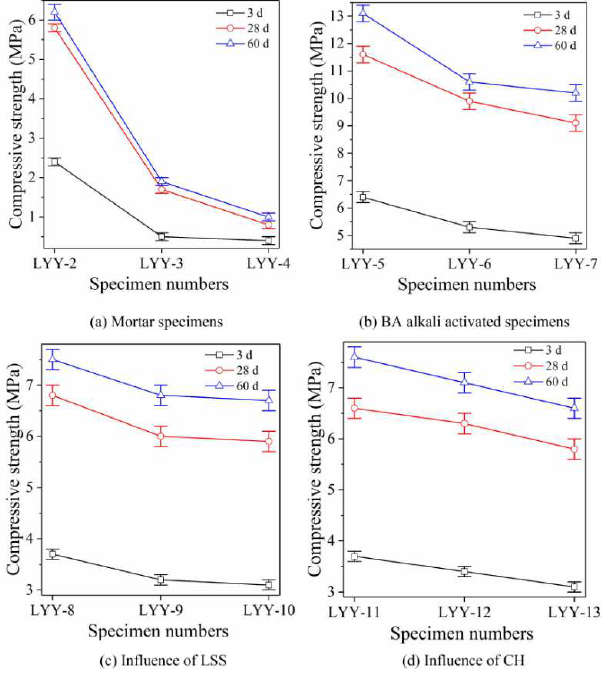
Figure 3. Analysis of mechanical properties of cement and bottom ash alkali-activated